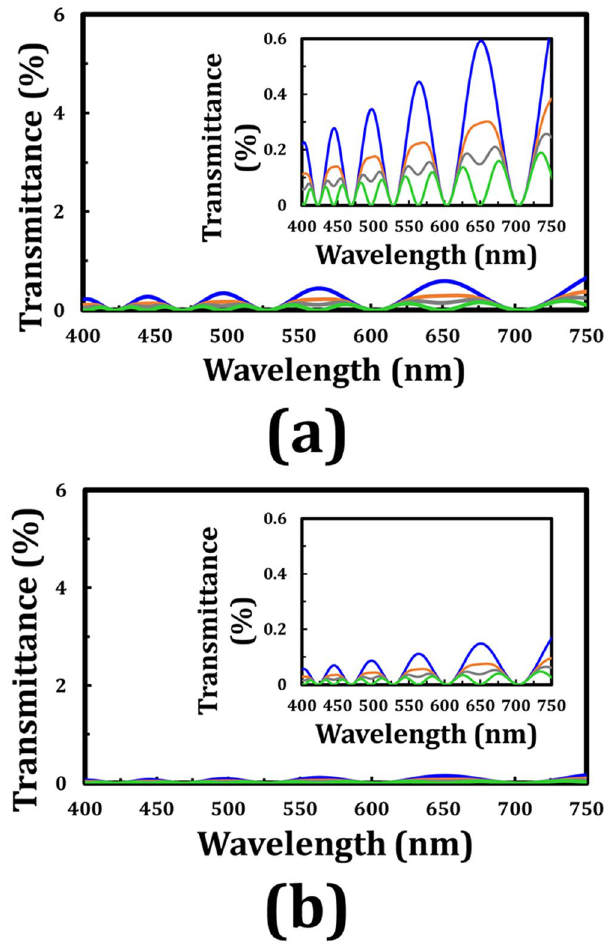
Figure 4. Theoretical transmittance (Jones Calculus) of the output beam through a tandem-2 φ -TNLC cell and an analyzer with its transmissive axis of 90° + 2 φ with respect to that of the polarizer ( β ) versus the wavelength of the input beam at different β angles with φ of ( a ) 45° and ( b ) 22.5°. Blue, orange, gray, and green curves represent the different β angles of 0°, 22.5°, 30°, and 45°, respectively. Insets evidently show the details of the spectra. The refractive index dispersion of the adopted LC (E7) for these theoretical analyses is not